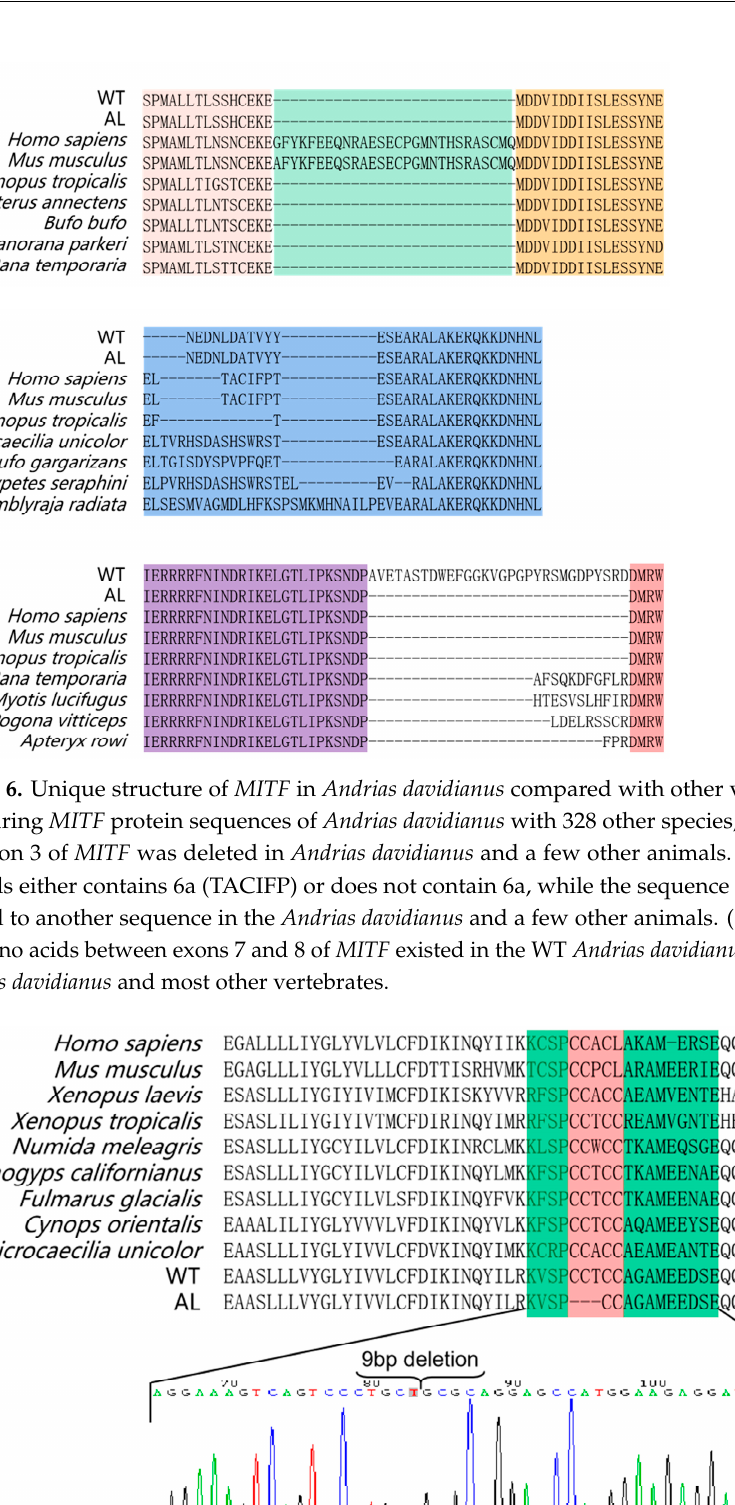
12 of 21 Figure 5. Di ff erential splicing form of MITF between WT and AL Andrias davidianus . ( A ) Amino acid